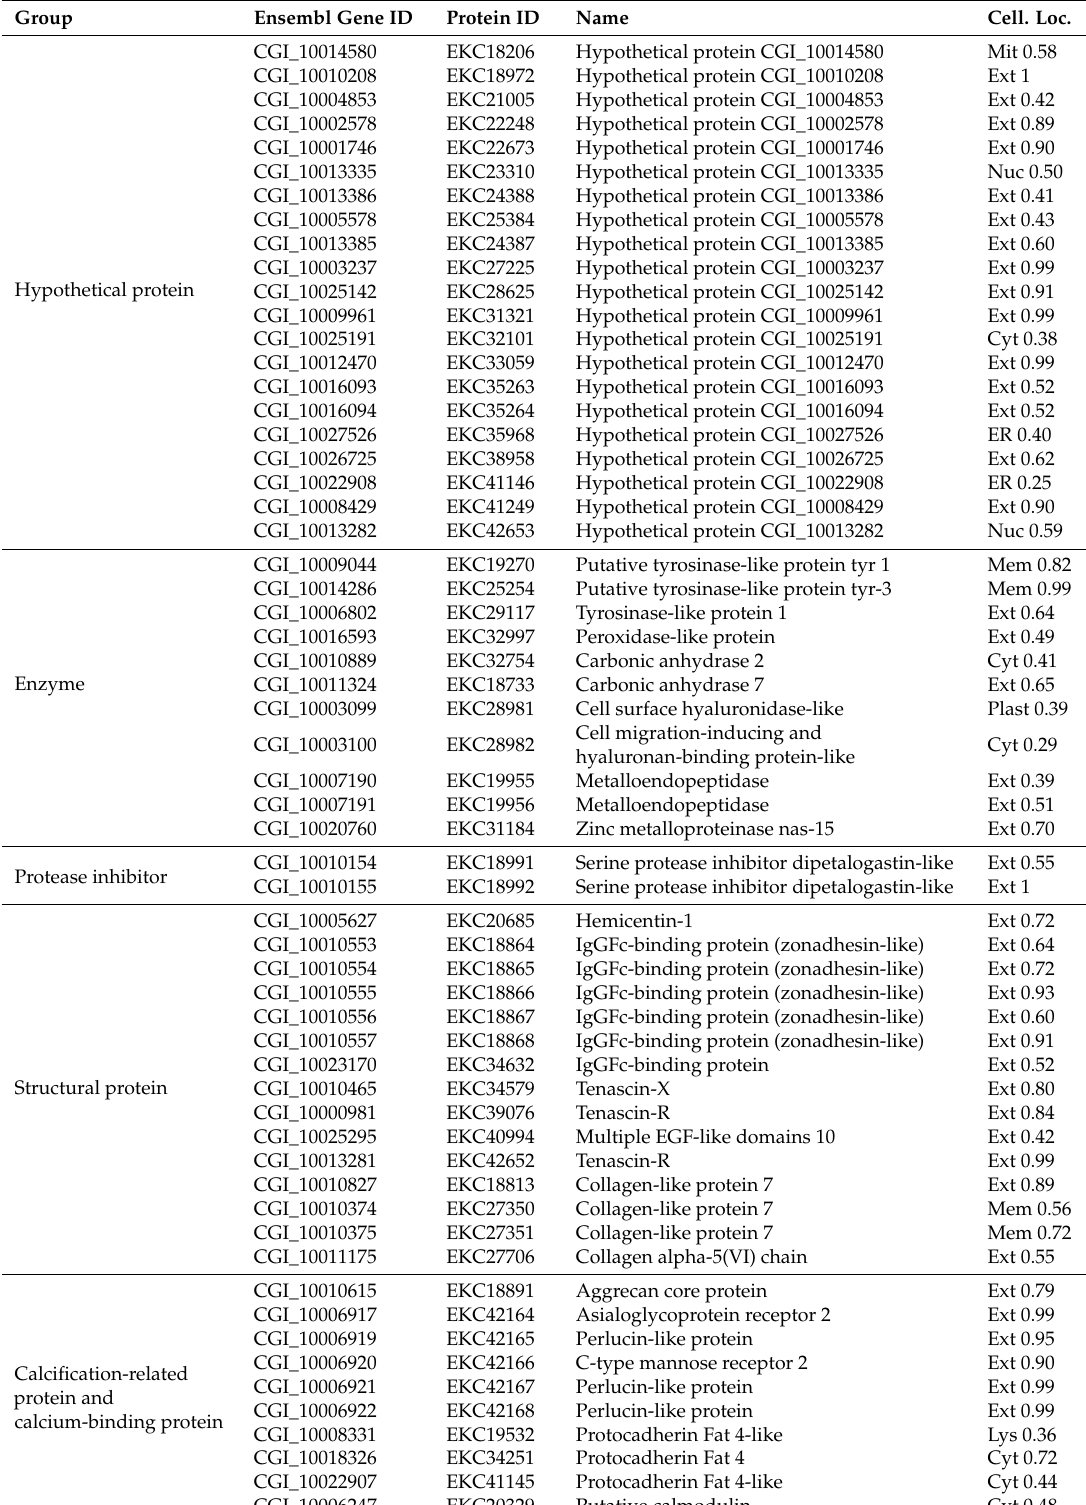
Table 1. Genes specifically expressed at the pediveliger stage of Crassostrea gigas according to the selection of RPKM from transcriptomic data published by Zhang et al. (2012) [24].